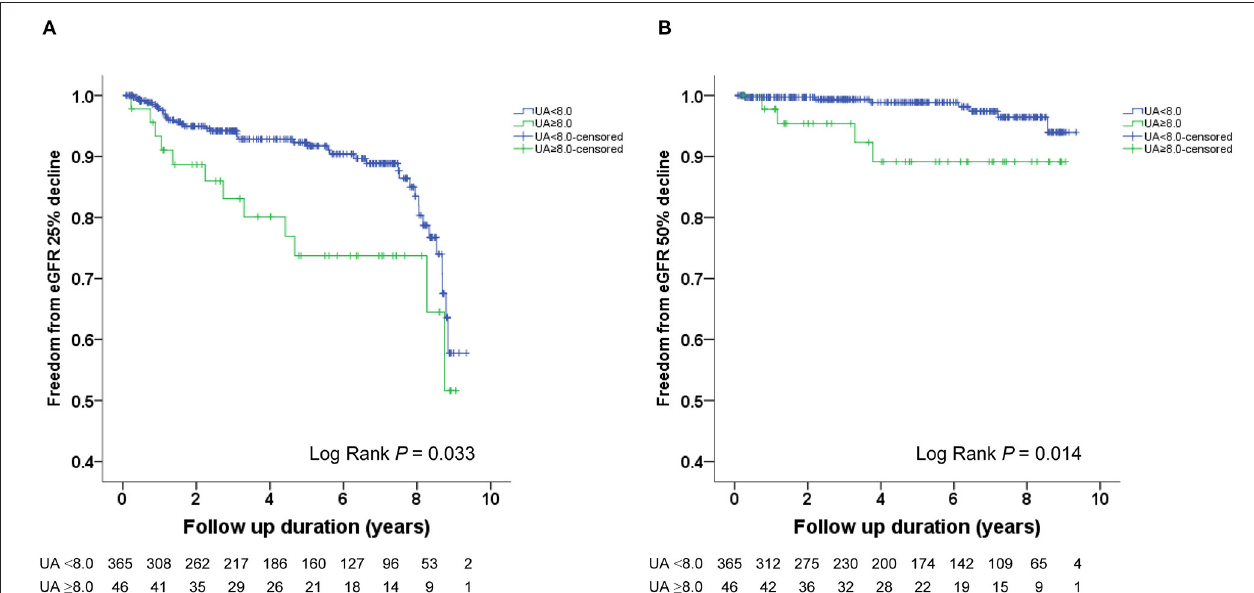
FIGURE 1 | Kaplan-Meier survival curves showing the absence of renal events according to the baseline uric acid (UA) in patients with hypertension. All participants were divided into two groups according to UA levels. The blue line represents the patient group with UA < 8.0 mg/dL. The green line represents the group with UA ≥ 8.0 mg/dL. Renal events were defined as > 25% decline and > 50% decline in eGFR. Differences were compared using the log-rank test. (A) UA ( < 8.0 vs. ≥ 8.0 mg/dL) and > 25% decline in eGFR ( P = 0.033). (B) UA ( < 8.0 vs. ≥ 8.0 mg/dL) and > 50% decline in eGFR ( P = 0.014).